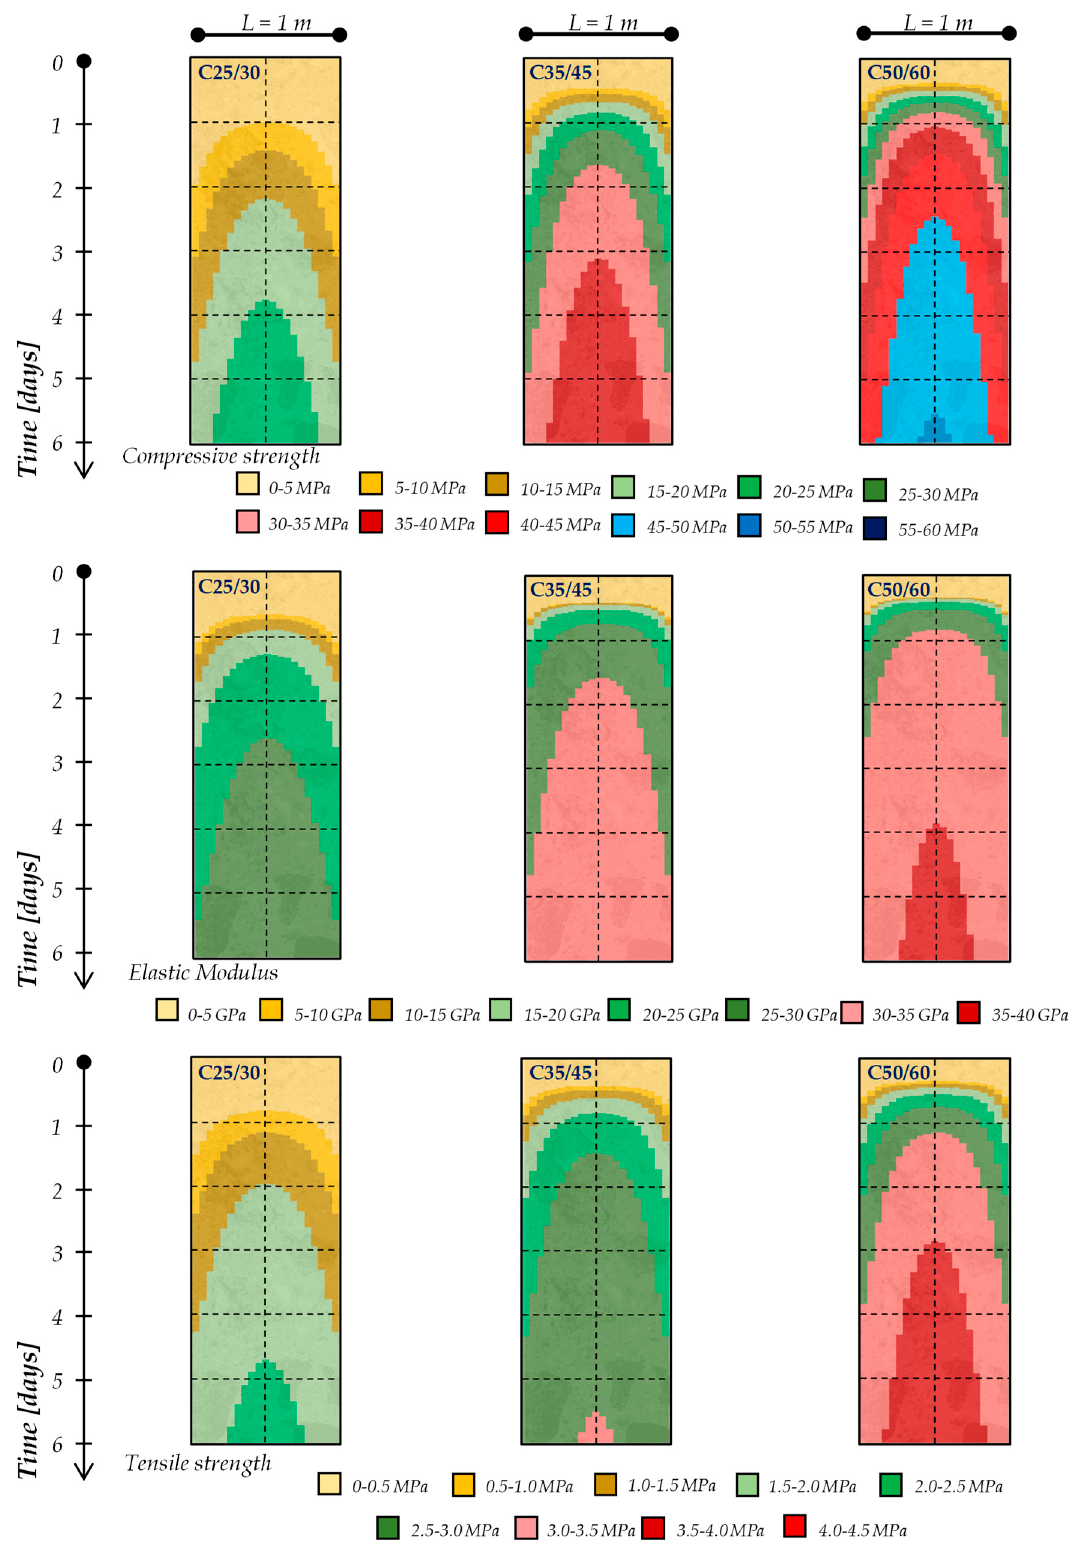
Figure 10. Early-age mechanical properties of 1-m thick concrete elements.